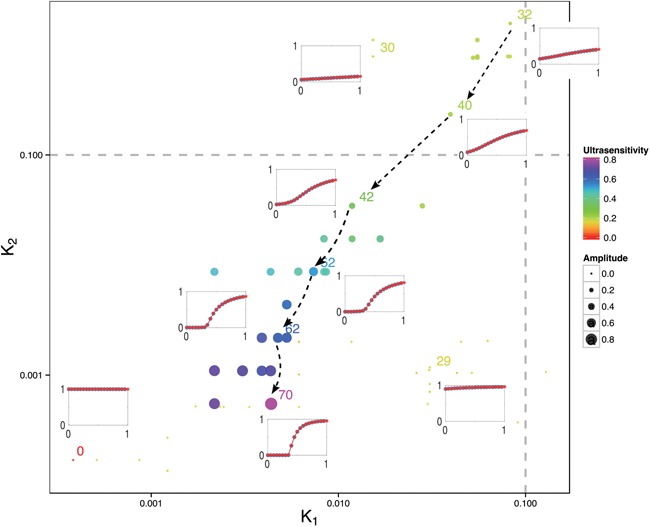
Evolution of model parameters for a sample evolutionary simulation with \documentclass[12pt]{minimal}
\usepackage{amsmath}
\usepackage{wasysym}
\usepackage{amsfonts}
\usepackage{amssymb}
\usepackage{amsbsy}
\usepackage{upgreek}
\usepackage{mathrsfs}
\setlength{\oddsidemargin}{-69pt}
\begin{document}
}{}$\omega _c = 0$\end{document} and selecting for ultrasensitivity. Each dot represents a model from different points in the evolutionary simulation (as indicated by the generation number on each dot), while the x- and y-axis show the composite parameters, \documentclass[12pt]{minimal}
\usepackage{amsmath}
\usepackage{wasysym}
\usepackage{amsfonts}
\usepackage{amssymb}
\usepackage{amsbsy}
\usepackage{upgreek}
\usepackage{mathrsfs}
\setlength{\oddsidemargin}{-69pt}
\begin{document}
}{}$K_1$\end{document} and \documentclass[12pt]{minimal}
\usepackage{amsmath}
\usepackage{wasysym}
\usepackage{amsfonts}
\usepackage{amssymb}
\usepackage{amsbsy}
\usepackage{upgreek}
\usepackage{mathrsfs}
\setlength{\oddsidemargin}{-69pt}
\begin{document}
}{}$K_2$\end{document}, that give the average catalytic binding efficiency of the kinases and phosphatases to the target protein respectively. The catalytic binding efficiency is defined as the Michaelis Menten constant of the enzyme (kinase or phosphatase) over the total substrate concentration and the average is calculated as the geometric mean of individual binding efficiencies of the different kinases and phosphatases and their allosteric states: \documentclass[12pt]{minimal}
\usepackage{amsmath}
\usepackage{wasysym}
\usepackage{amsfonts}
\usepackage{amssymb}
\usepackage{amsbsy}
\usepackage{upgreek}
\usepackage{mathrsfs}
\setlength{\oddsidemargin}{-69pt}
\begin{document}
}{}$K_1 = \mathop \prod \limits_{i = 1}^m \sqrt[m]{{(K_1^{R_i } \cdot K_1^{T_i } )^{\frac{1}{2}} }}\;{\rm and}\;K_2 = \mathop \prod \limits_{j = 1}^n \sqrt[n]{{\left( {K_2^{R_j } \cdot K_2^{T_j } } \right)^{\frac{1}{2}} }}$\end{document}. The dot size and color indicate the response amplitude and ultrasensitivity. For selected networks the input-output response curve is also shown. Dashed lines with arrow heads show the trend of how ultrasensitivity increases with the evolution of decreasing values of \documentclass[12pt]{minimal}
\usepackage{amsmath}
\usepackage{wasysym}
\usepackage{amsfonts}
\usepackage{amssymb}
\usepackage{amsbsy}
\usepackage{upgreek}
\usepackage{mathrsfs}
\setlength{\oddsidemargin}{-69pt}
\begin{document}
}{}$K_1 {\rm and}K_2$\end{document}. The initial network starts in the bottom left corner (network 0) moves to the bottom right corner (network 29) and then to the top right corner (network 32).